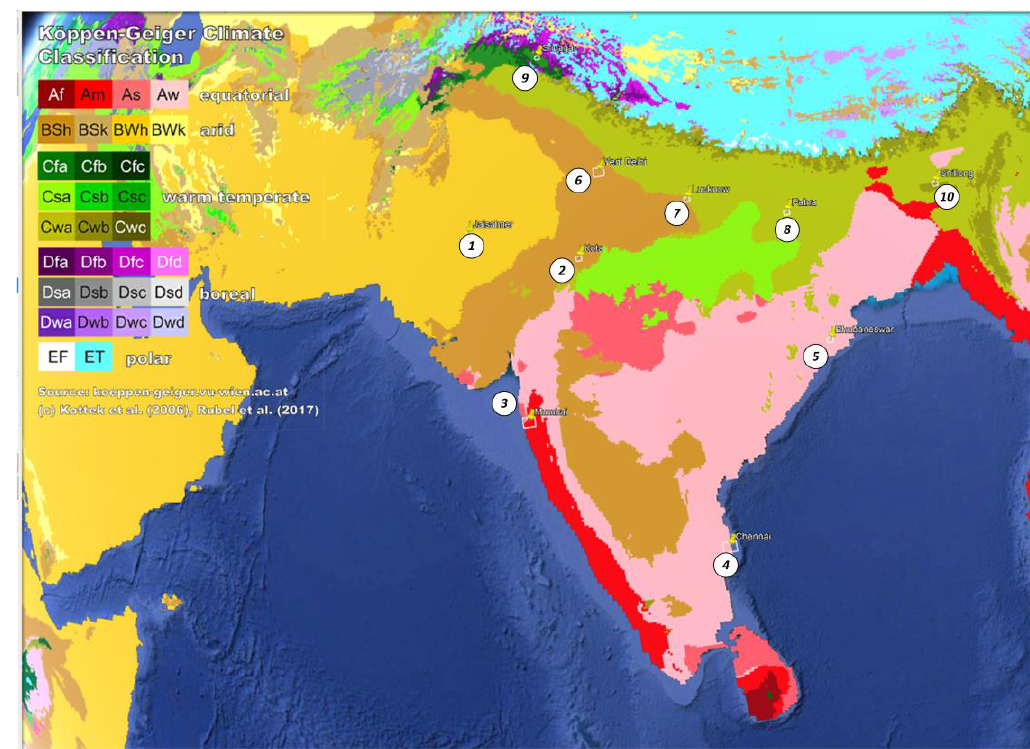
Figure 1. Selected Indian cities’ geographic locations. Table 1. Cooling and heating values of the selected cities [23].